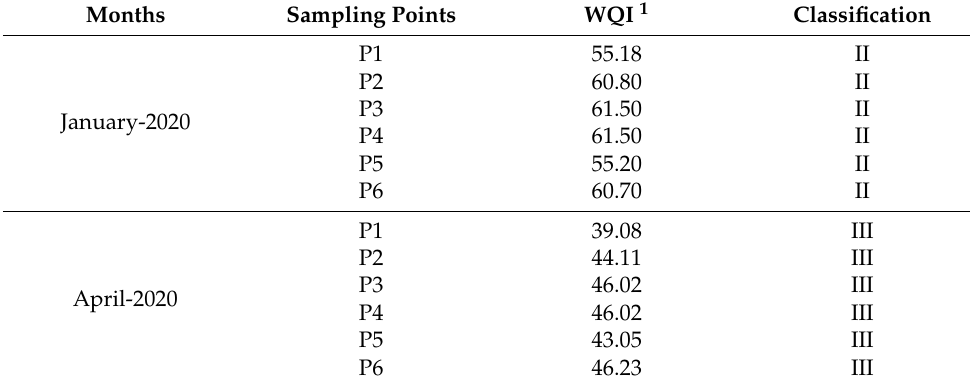
Table 4. WQI and classification of the sampling points.